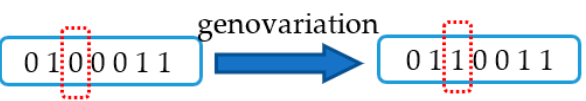
Figure 9. Diagram of variation.